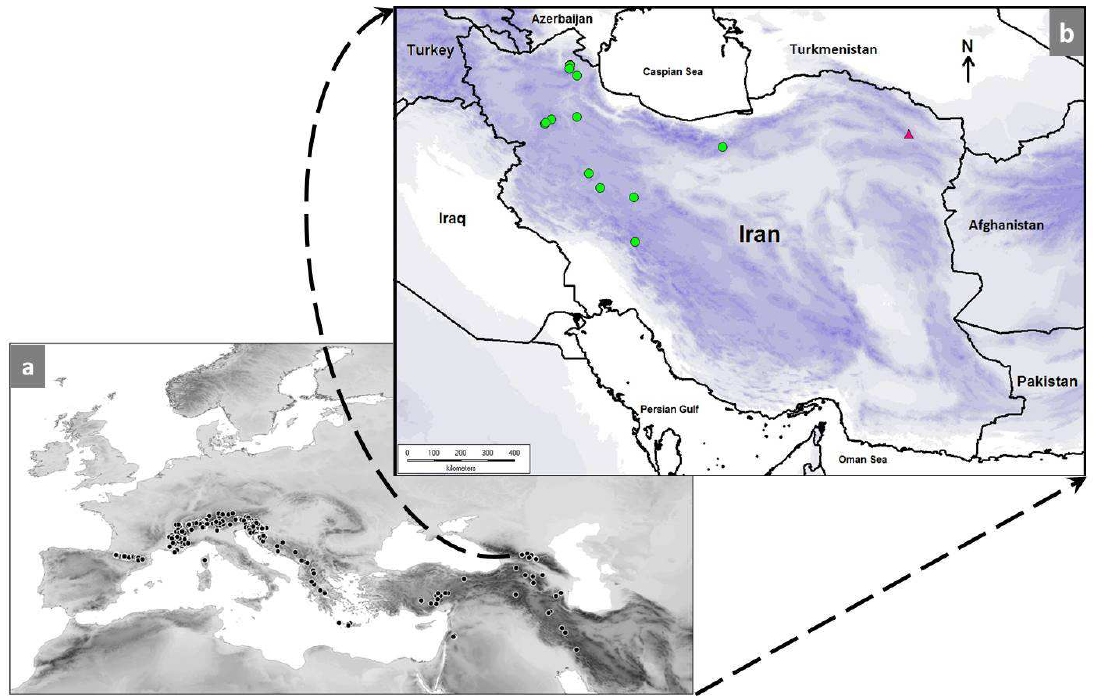
F IGURE 2. Records of P. macrobullaris on elevation map: a) The Western Palearctic (Alberdi et al., 2013) and b) Iran (Benda et al., 2012) (green circles), and present study (red